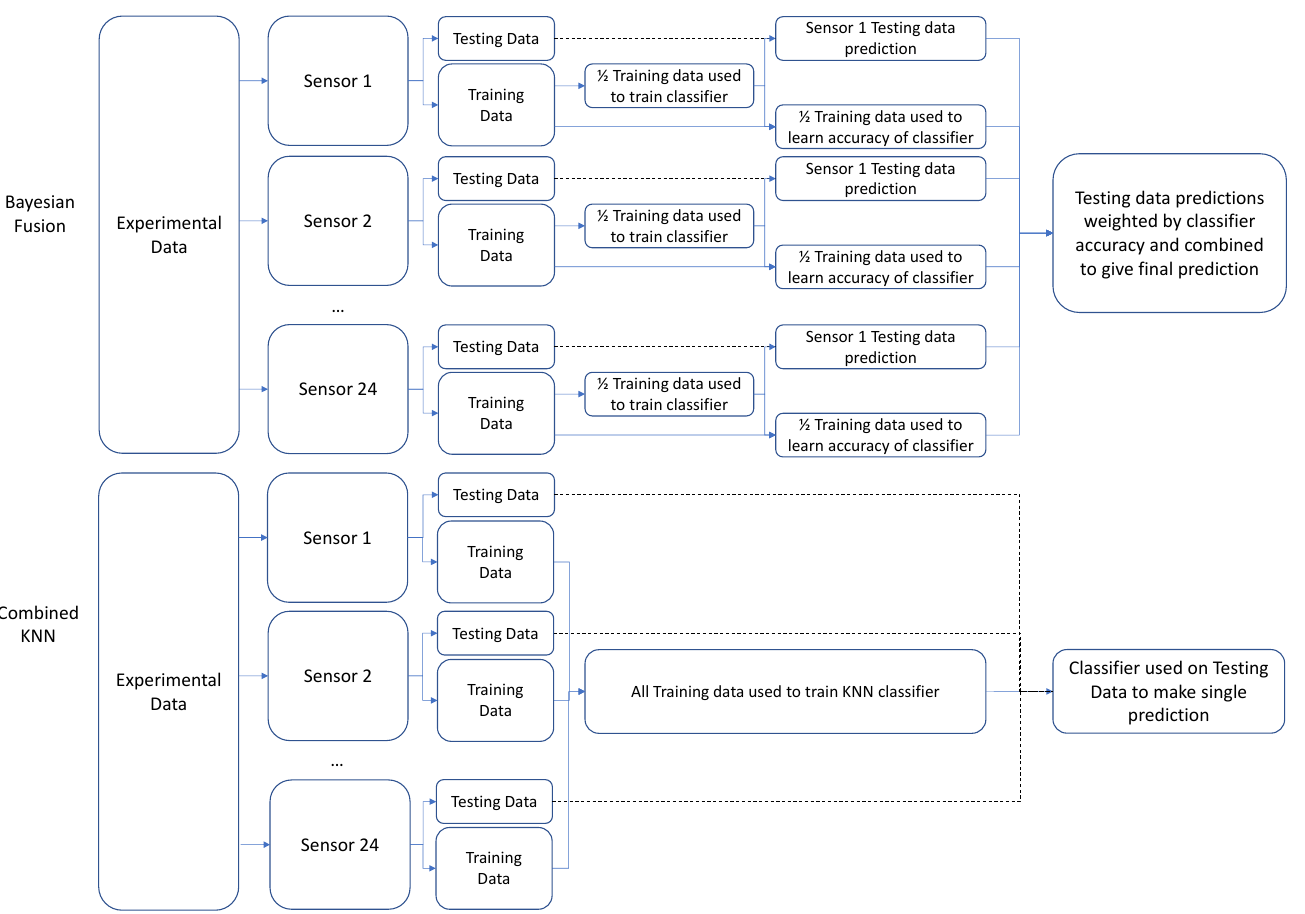
Figure 4. Overall pipeline of training and testing for the two algorithms. The Bayesian Fusion (MM) algorithm divides the training dataset into Classifier Training and Probability Learning subsets. The Classifier Training Set is used to train the classifier for each sensor, and then the Probability Learning set is used to populate the confusion matrix for each classifier. The confusion matrix then provides weightings for each sensor’s contribution to the overall network output, which is used to predict the class of the testing set. The Combined KNN (NMM) does not subdivide the training set, instead using all sensor data to train a single classifier, which then predicts the class of the testing set. Dashed lines indicate testing